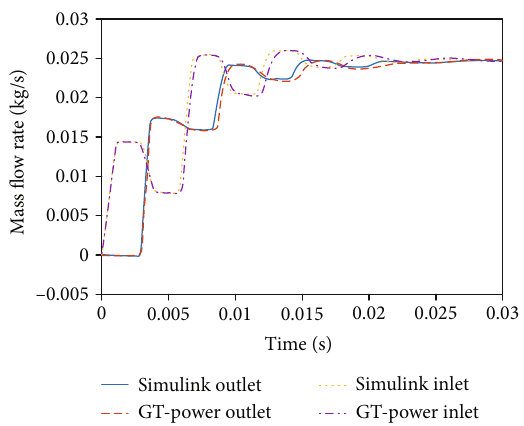
Figure 13: Simulated inlet and outlet mass fl ow rates from GT- POWER and